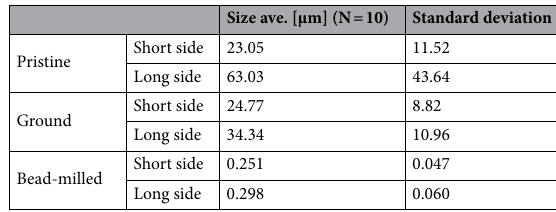
Table 1. Average size and standard deviation of 10 particles prepared under each